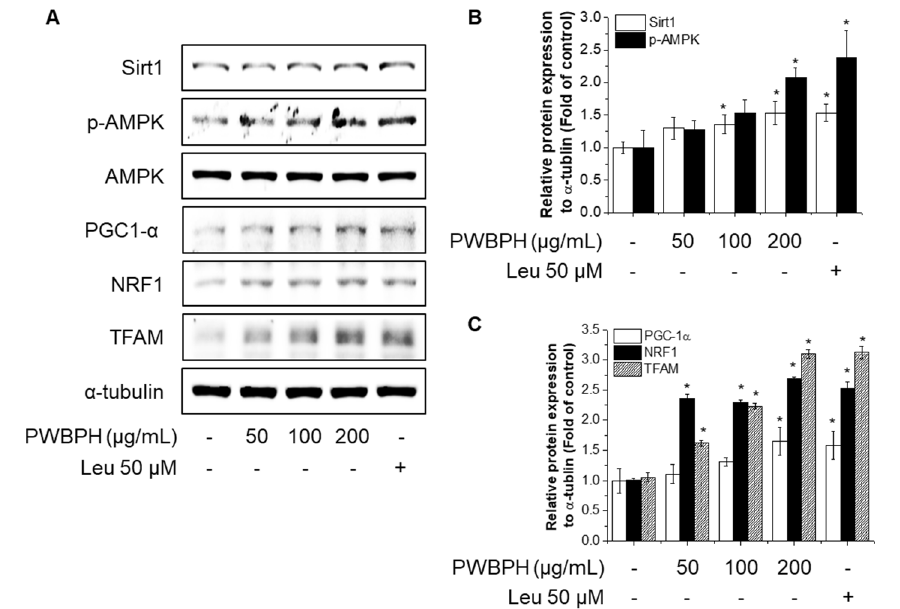
Figure 6. Effect of PWBPH on mitochondrial function-related protein expression in C2C12 myotubes. About 90% confluent C2C12 cells cultured in differentiation medium for 4 days and then cells were treated with PWBPH (50, 100, or 200 μ g/mL) and Leu (50 μ M) for 3 days. ( A ) The protein levels of SIRT1, p-AMPK, PGC-1 α , NRF1, and TFAM were determined by Western blotting and ( B , C ) the band intensities were measured using ImageJ software. * p < 0.05 vs. control group.